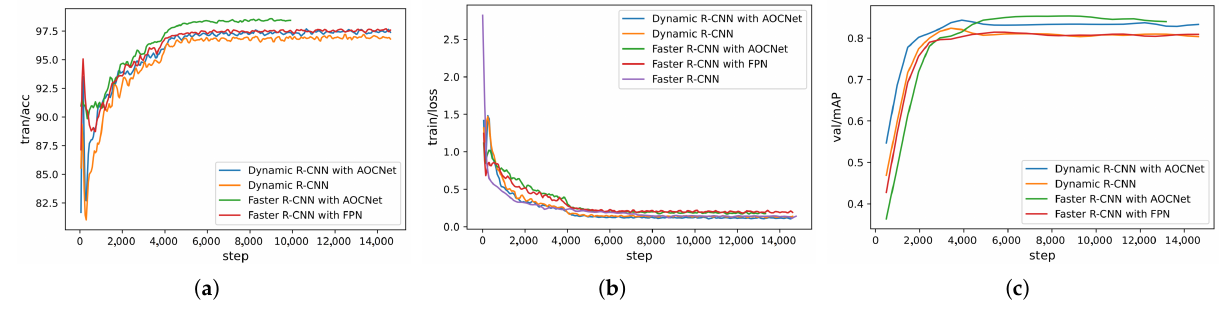
Figure 14. The results on the NWPU VHR-10 dataset. ( a ) Accuracy. ( b ) Loss. ( c ) mAP.